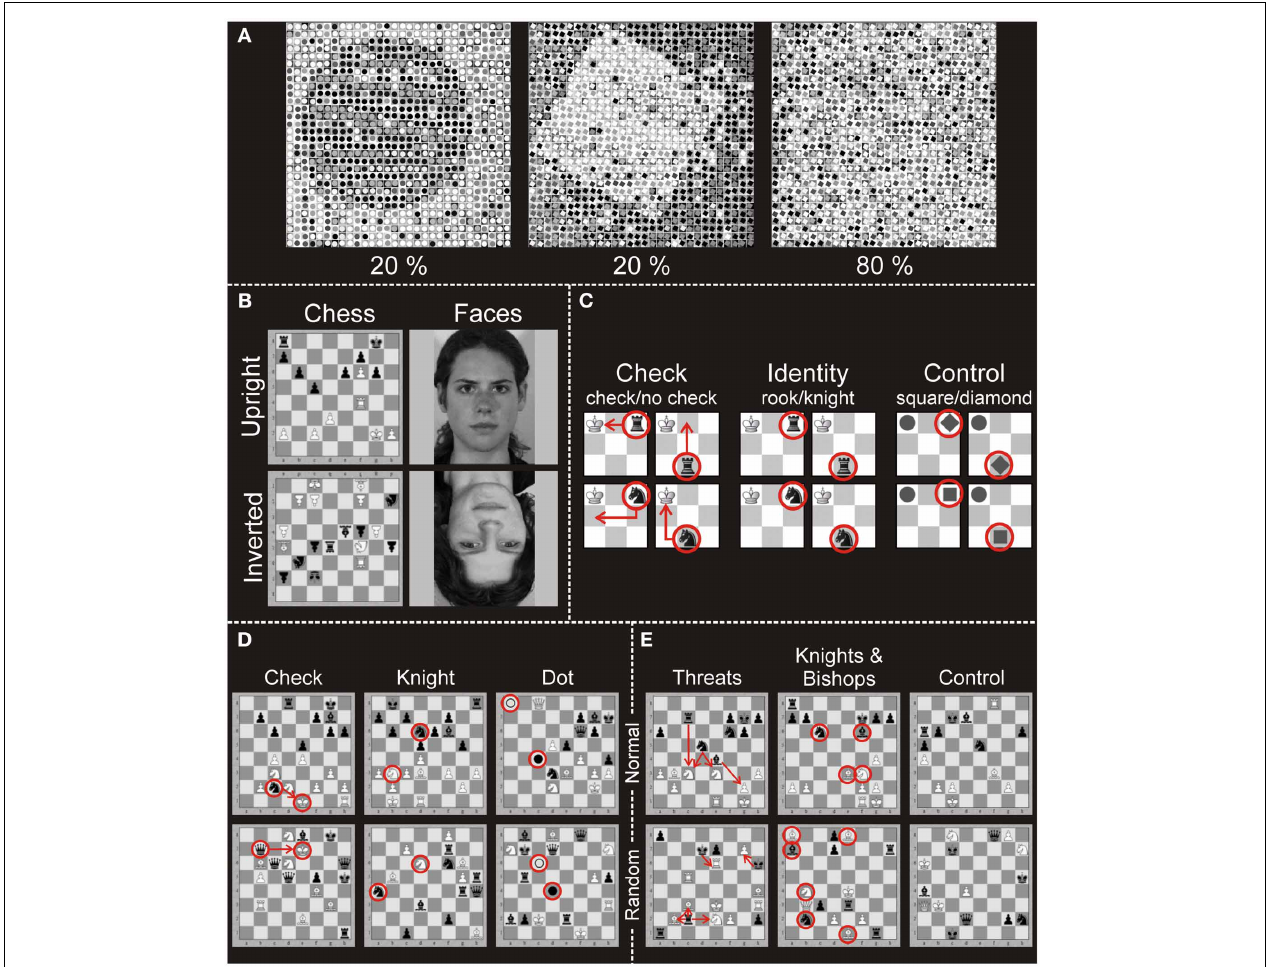
FIGURE 1 | Stimuli applied in the different experiments. (A) Illustration of the global stimuli used in the experiment of Huberle and Karnath (2012). The pictures show two 20% scrambled global objects (circle, square; intact global perception) and one 80% scrambled global object (disturbed global perception). (B) Stimuli used in Experiment 1 (Bilali´c et al., 2011b). Pictures of full-board chess positions or faces were presented upright or inverted. Participants had to indicate whether the currently presented stimulus matched the previously presented stimulus. (C) Stimuli of Experiment 2 (Bilali´c et al., 2011a). The stimuli were presented on a 3 × 3miniature chess board. In the check task participants indicated whether the black piece (knight or rook) gives the white king check. In the identity task participants indicated whether the presented black piece is a rook or a knight. In the control task participants identified geometrical shapes (square or diamond). (D) Stimuli